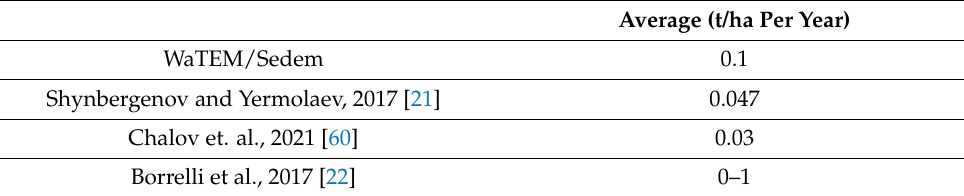
Table 5. Gross erosion values (t/ha per